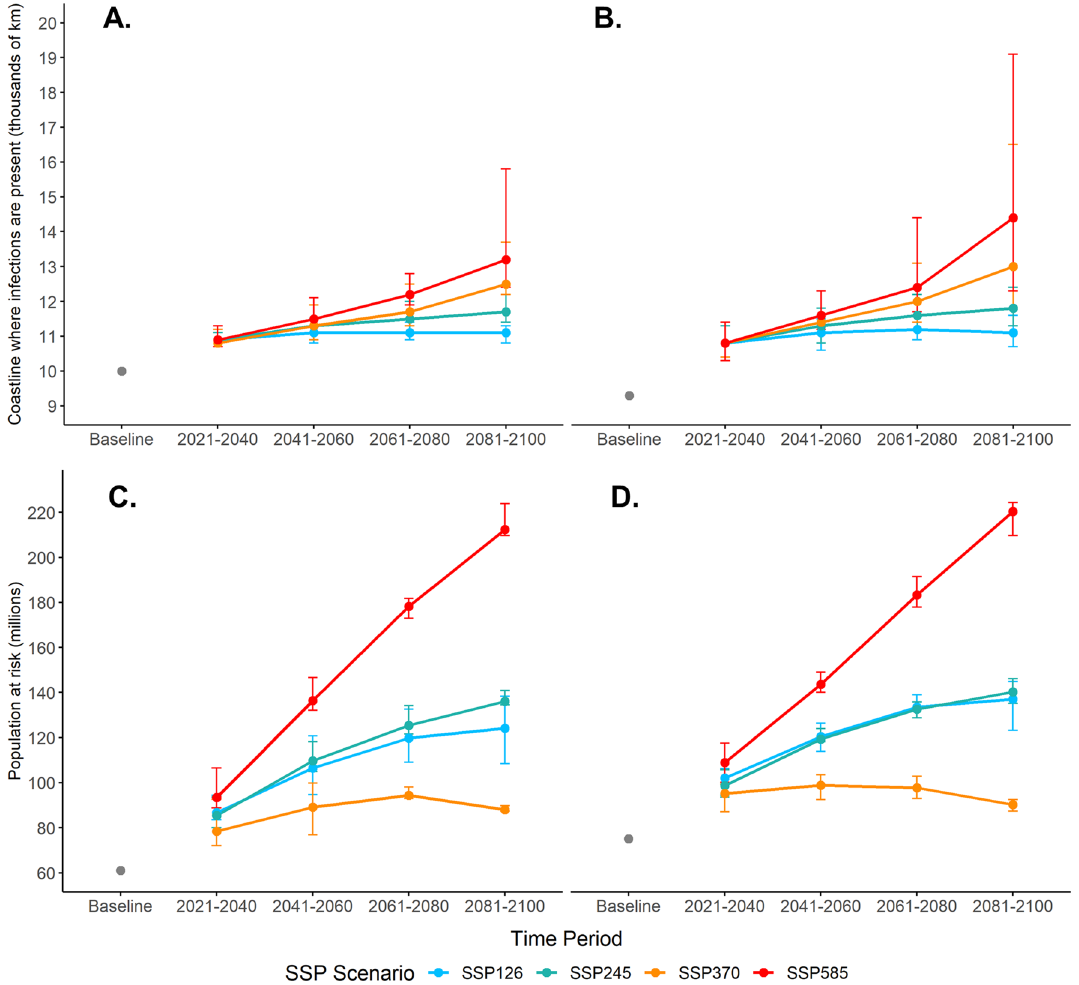
Figure 5. Length of the coastline where V. vulnificus infections are present (thousands of km) for the tmean ( A ) and tmax model ( B ). Total population at risk (millions) for the tmean ( C ) and tmax model ( D ). Future values represent an average across seven CMIP6 GCMs. Error bars represent the highest and lowest estimate from individual GCM predictions.